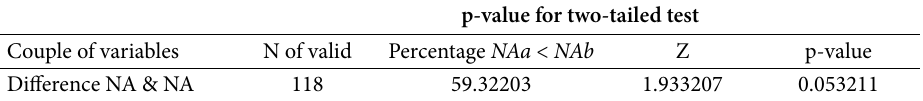
Table 9. The sign test for the category of large companies at p < 0.05 significance level p-value for two-tailed test Couple of variables N of valid Percentage NAa < NAb Z p-value Difference NA & NA 118 59.32203 1.933207 0.053211